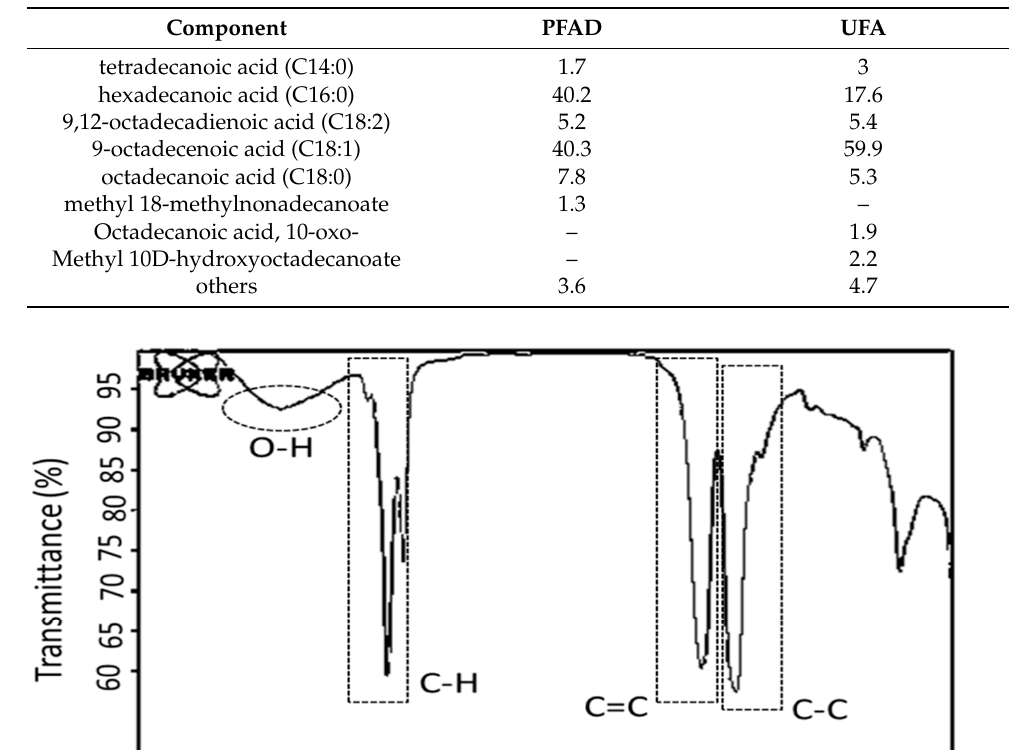
Table 1. GC-MS analysis of PFAD and UFA.